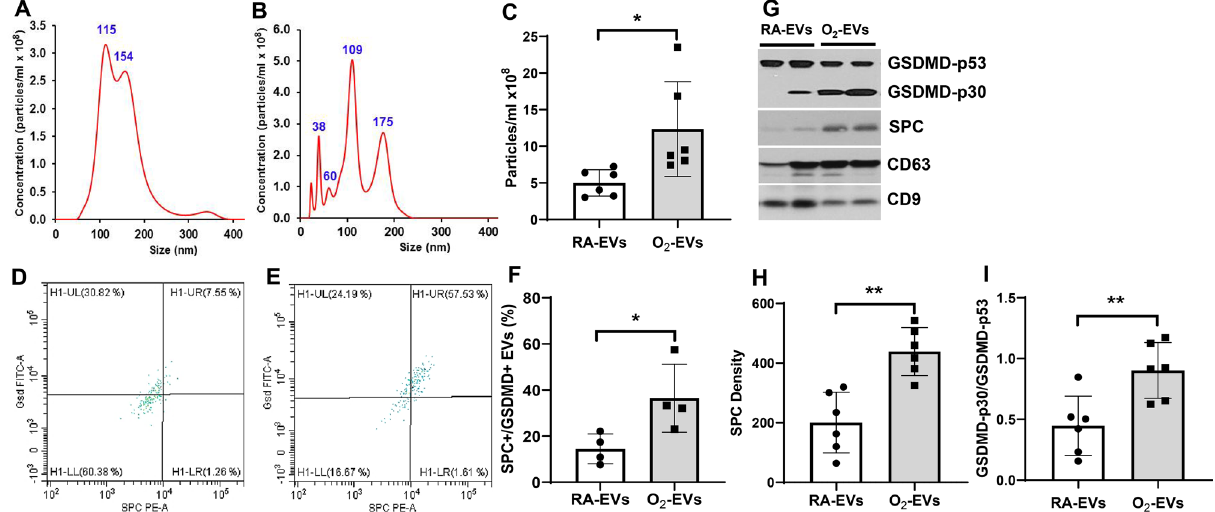
Figure 1. Hyperoxia stimulates the release of EVs with an increased cargo of SPC/GSDMD into the circulation of neonatal rats. Newborn rats on postnatal day 1 (P1) were exposed to room air (RA) or hyperoxia, 95% O 2 (O 2 ) for 14 days and EVs were isolated from the plasmas of these animals. Nanosight tracking assay showed that both room air-exposed EVs (RA-EVs, ( A )) and hyperoxia-exposed EVs (O 2 -EVs, ( B )) contained particles that were prodominately 100–150 nm in diameter, but O 2 -EVs had increased particle concentrations as compared to RA-EVs (( C ), n = 6/group, * P < 0.05). FACS analysis demonstrated that RA-EVs ( D ) had a smaller population of SPC + /GSDMD + EVs compared to O 2 -EVs ( E ) (( F ), n = 4/group, * P < 0.05). ( G ) Representative Western blots of SPC, GSDMD, CD9 and CD63. O 2 -EVs had increased cargos of SPC ( H ) and GSDMD-p30 ( I ) compared to RA-EVs (n = 6/group, ** P <